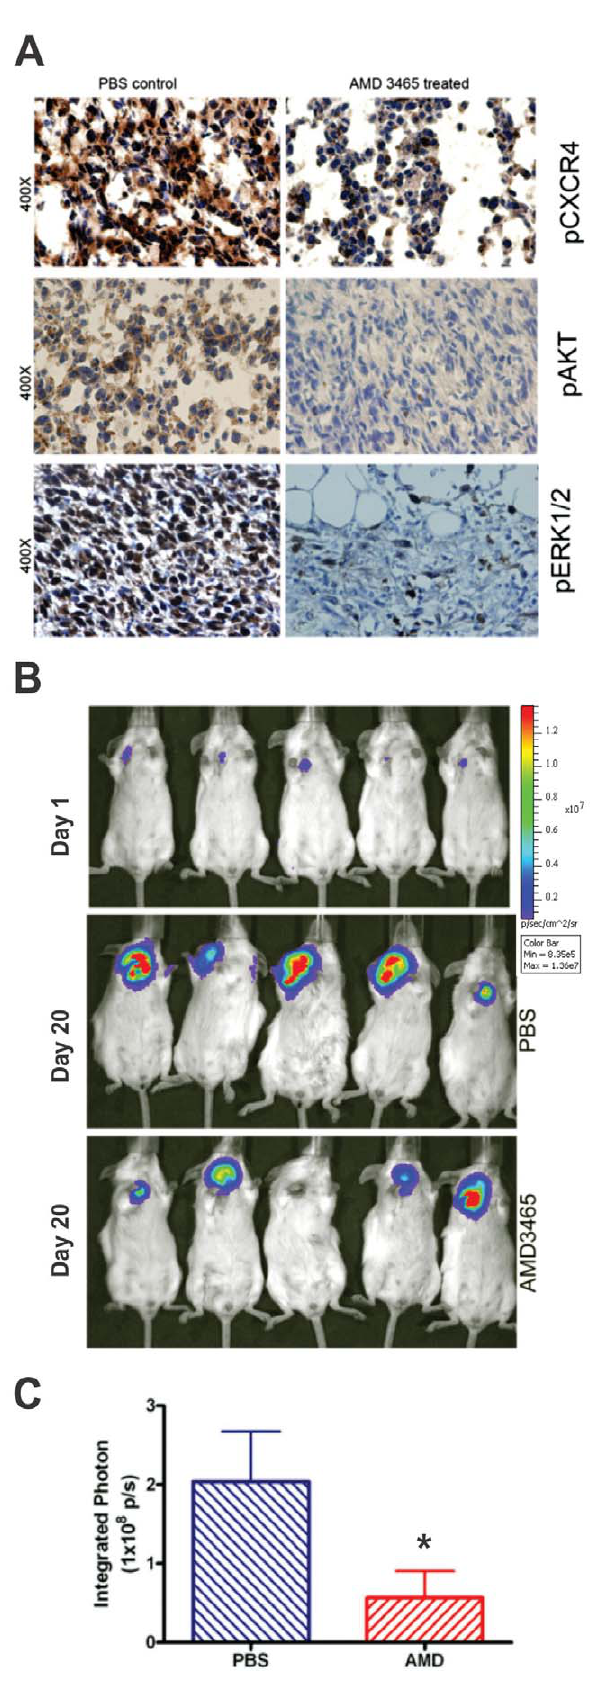
Figure 3. AMD3465 inactivates CXCR4 in 4T1 tumors and slows tumor progression. A, Tumor-bearing mice were injected with AMD3465 a single subcutaneous dose of 2.5 mg/kg. The tumor tissue was collected 1 h after treatment and sectioning was carried out. Immunohistochemical staining of pCXCR4, pAKT and pERK1/2 positive tumor cells can be seen in PBS controls compared to AMD3465 treated tumor sections. The slides were analyzed with an Olympus BX 41 microscope equipped with a digital camera (Olympus DP70). B, The top panel illustrates the BLI of 5 representative mice 1 d after injection of the 4T1 cells. The middle panel shows representative BLI in 5 mice treated with PBS 20 d after tumor injection, and the lower panel displays imaging of the 4T1 tumor masses following a similar exposure to AMD3465 (please see the Methods section for details). C, A bar graph representation of the end-point integrated photon (photons/cm 2 /sec) data collected in the experiment described in B . The tumor size was measured by BLI between control mice (n=5) and AMD3465-treated mice (n=10) and are expressed as the mean value 6 SD (*p ,